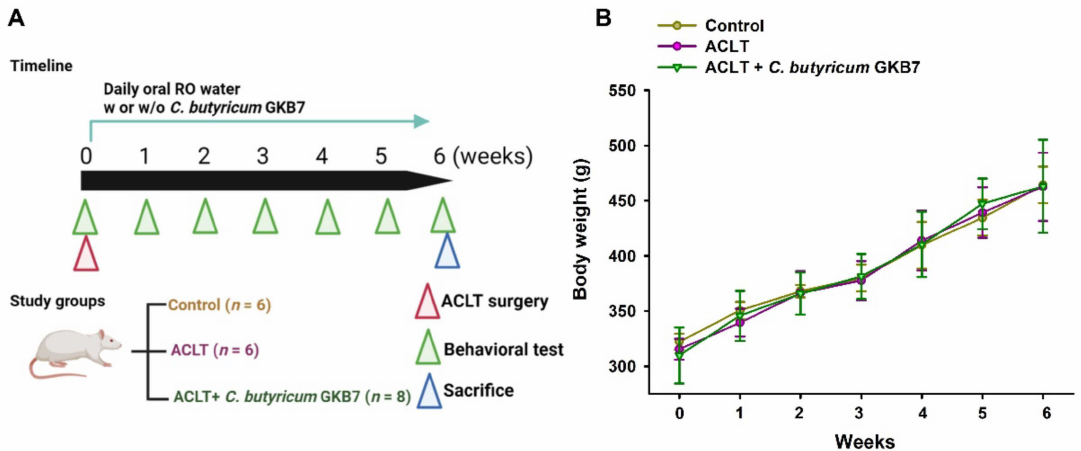
Figure 1. ( A ) Experimental design. ( B ) Body weights throughout the experimental period. Although the body weights of all rats increased during the experiment, the weekly measurements did not exhibit any significant variations between the study groups.